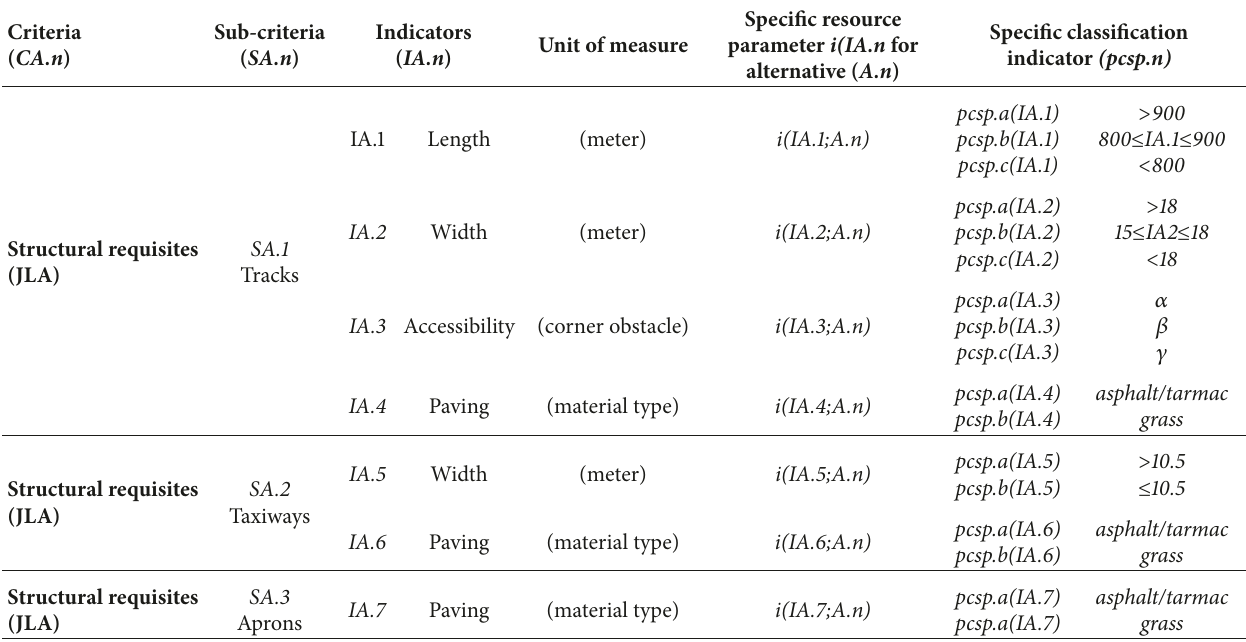
Figure 5: The geographical areas of analysis for the JLD: “territorial attractiveness classification” example for Arezzo airport “E. Bartolini”. Table 1: Evaluation Elements for JLA “structural